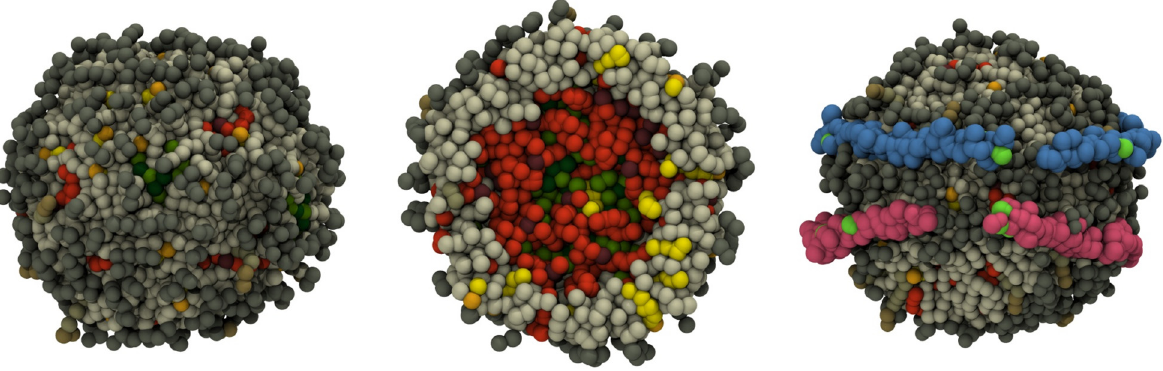
Figure 2. Example of a protein-free lipid droplet (left), its molecular distribution shown through a slice across the particle (middle), and HDL including two apoA-I proteins (right). Dark gray stands for POPC headgroup and dark brown for PPC headgroups, light gray for POPC hydrocarbon chains, light brown for PPC chains, light orange for CHOL OH-groups, bright yellow for cholesterol body, dark orange for CE ester bond, orange for CE ester body and chain, dark green for TG ester bonds, and bright green for TG chain. In HDL, proline residues in apoA-I sequences are in green.